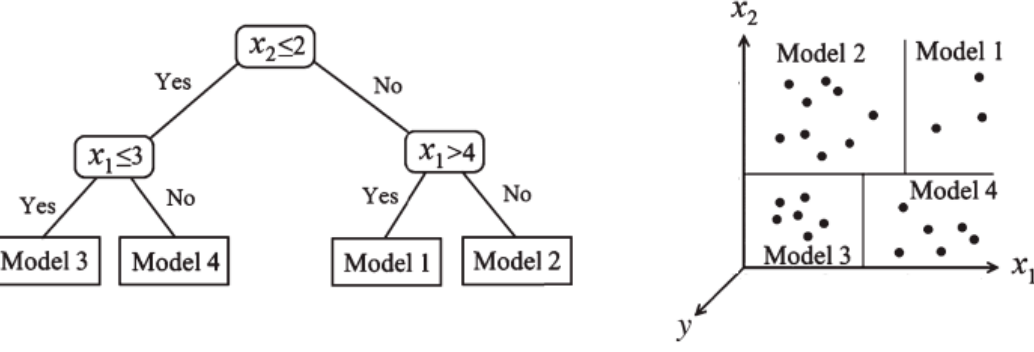
Figure 2. M5 tree; splitting the input space into subspaces and the resultant diagram [47].